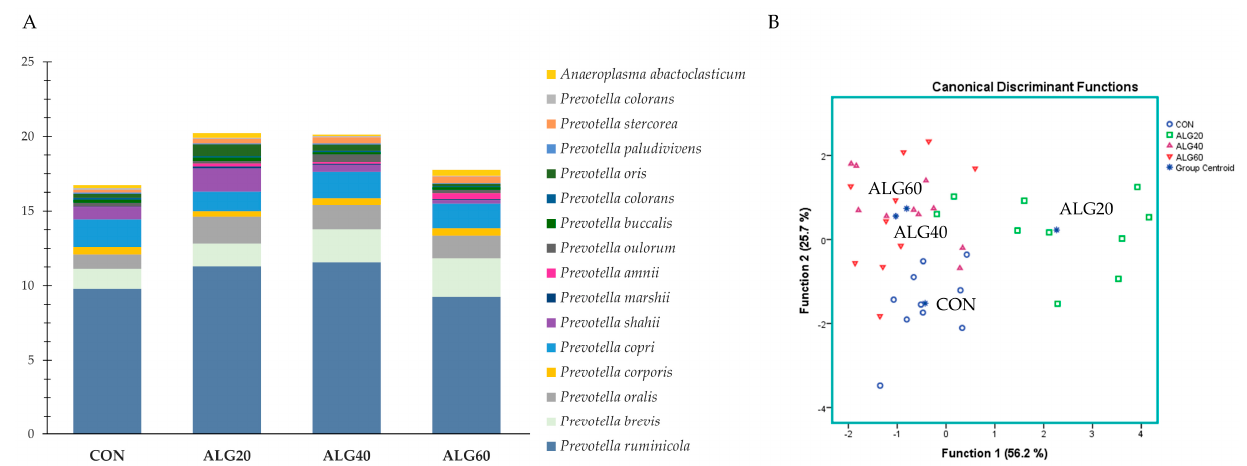
Figure 4. ( A ) Abundances of the most representative proteolytic species in the four dietary treatments (CON, ALG20, ALG40, and ALG60) within the two sampling times (20th and 40th days) illustrated in clustered stacked columns. ( B ) Discriminant plots separating the four dietary treatments (CON, blue ○ ; ALG20, green □ ; ALG40, purple △ ; and ALG60, red ▽ ) according to the pooled data of the two sampling times (20th and 40th experimental days) entered together as independents on the abundances of the sixteen principal species with proteolytic activity in the goats’ rumen. CON = control concentrate without microalgae ( Schizochytrium spp.); ALG20 = CON with 20 g/Kg Schizochytrium spp.; ALG40 = CON with 40 g/Kg Schizochytrium spp.; ALG60 = CON with 60 g/Kg Schizochytrium spp.